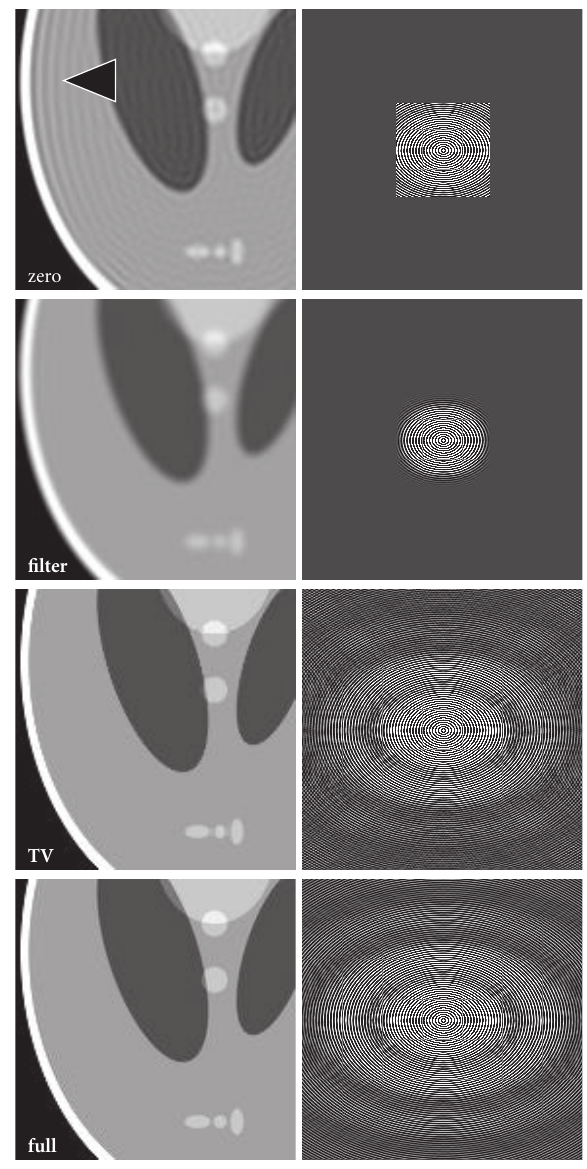
Figure 2: (Left) Images of the numerical Shepp-Logan phantom (96 × 96 samples, 288 × 288 reconstruction matrix) and (right) corresponding k -space representations reconstructed using zero- padding (zero), filtered zero-padding (filter), and the proposed extrapolation method (TV). For comparison, a data set with a fully sampled 288 × 288 matrix is shown (full). Arrow = truncation